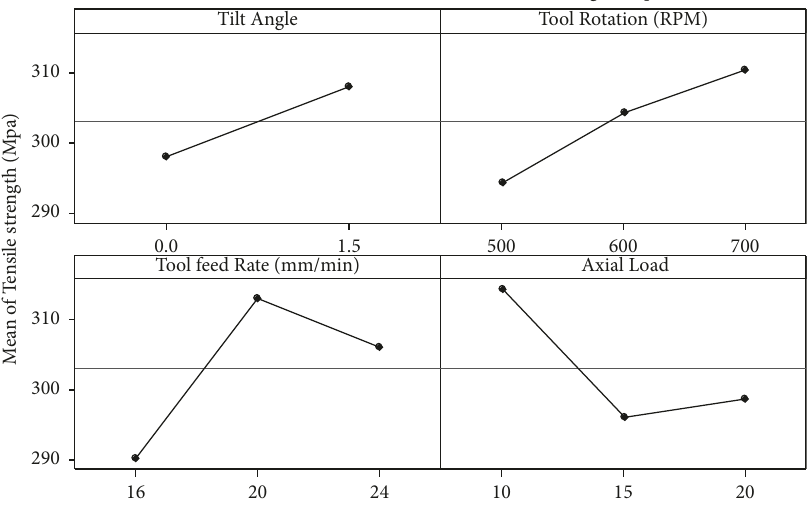
Figure 2: Main effect plot for tensile strength of FSW